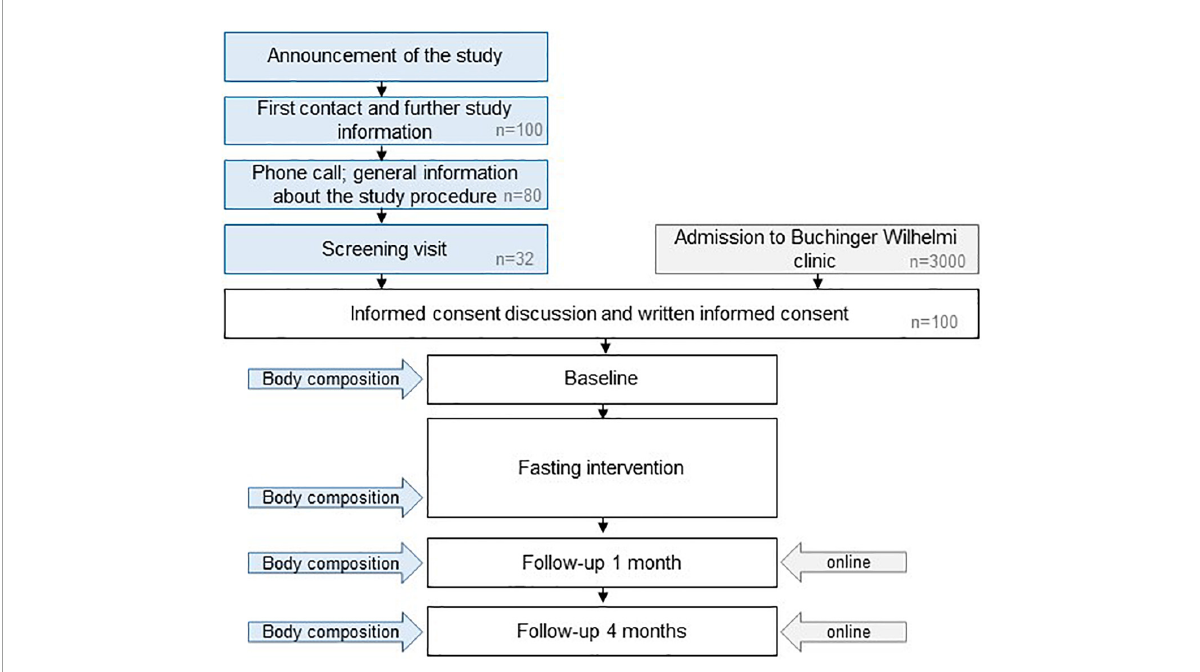
FIGURE2 Study design. Specific sessions for the subjects enrolled in the first stage of the projects are indicated in blue. The estimated numbers of volunteers needed to recruit the sample size of 100 subjects are indicated in gray.